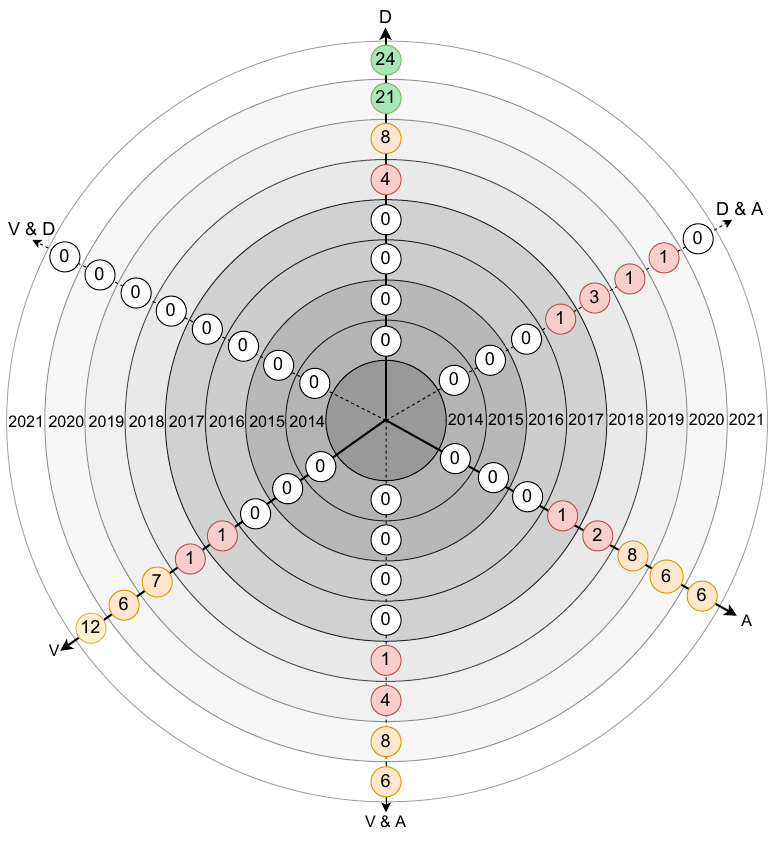
Figure 6. Number of attacks, vulnerabilities and defenses-related papers on multiple axis per